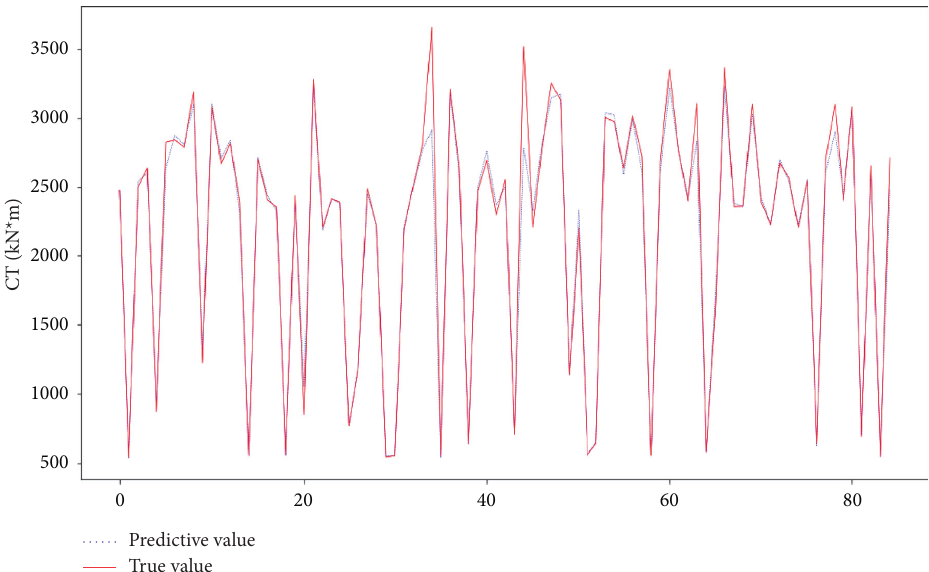
Figure 8: Effect of predicting cutterhead torque by using the RFM on the testing